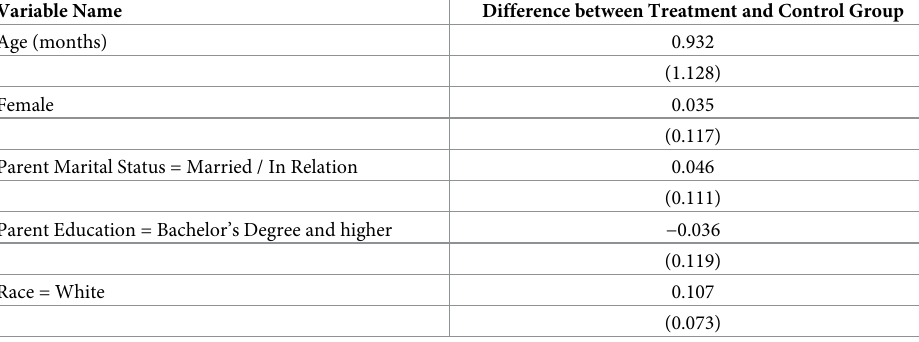
Table 4. Difference in the base characteristics of students in the treatment and control groups (N =